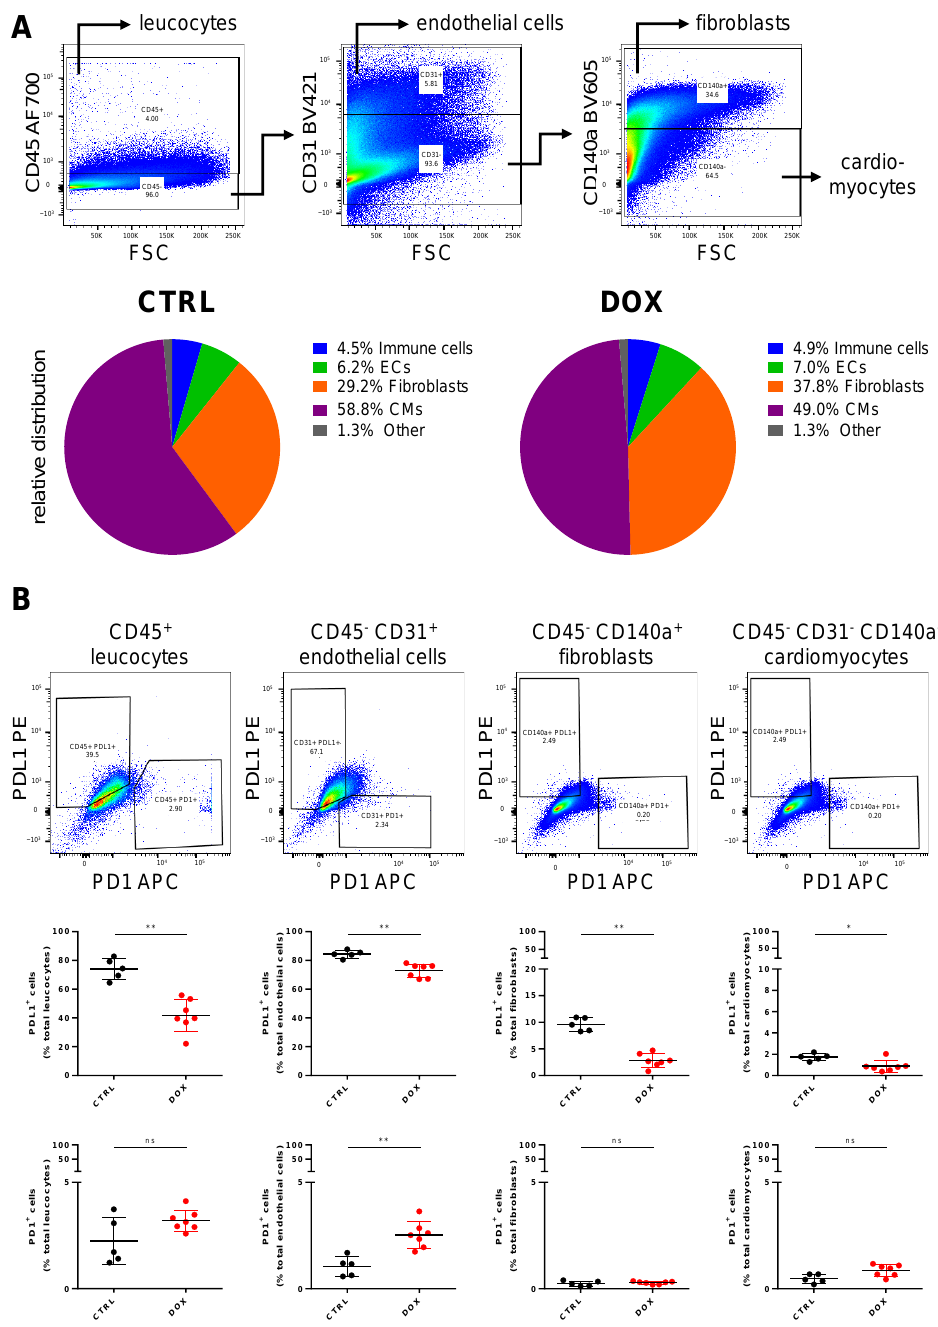
Figure 3. Doxorubicin modifies heart tissue composition and PDL1/PD1 expression on cardiac cells. ( A ) Top Exemplary pseudo-color dot plots for separation of cell populations in heart tissue using flow cytometry. Bottom Ratios of immune cells, endothelial cells (ECs), fibroblasts and cardiomyocytes (CMs) relative to total cell number measured in control (CTRL) and Doxorubicin (DOX) group. Dif- ferences in fibroblast and cardiomyocyte ratios is significant between both groups (n = 5–7, Student’s t -test, p < 0.05). ( B ) Top Exemplary pseudo-color dot plots for PD1/PDL1 expressing leucocytes, endothelial cells, fibroblasts and cardiomyocytes. Middle Percentage of PDL1 expressing cells of total leucocytes, endothelial cells, fibroblasts and cardiomyocytes from control (CTRL) and Doxorubicin (DOX) treated animals (n = 5–7, Mann–Whitney test, *: p < 0.05, **: p < 0.01). Bottom Percentage of PD1 expressing cells of total leucocytes, endothelial cells, fibroblasts and cardiomyocytes from control (CTRL) and Doxorubicin (DOX) treated animals (n = 5–7, Mann–Whitney test, **: p < 0.01). ns: not